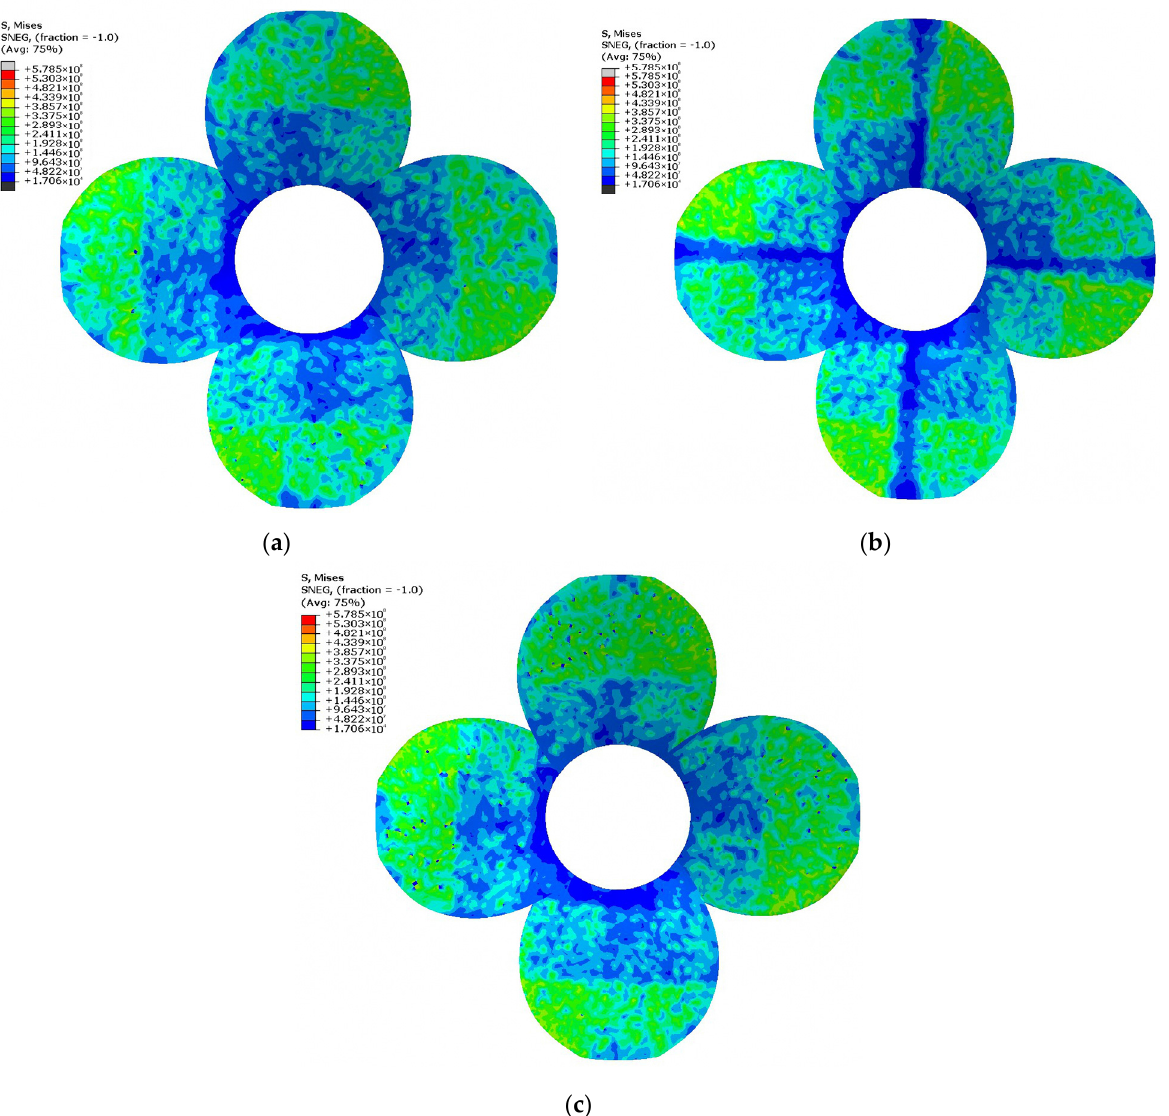
Figure 12. Comparison of the surface stress of the original propeller, the optimization 1 propeller, and the optimization 2 propeller during ice cutting. ( a ) Comparison of surface stress of parent propeller and ice cutting; ( b ) Optimization 1 comparison of surface stress between propeller and ice cutting; ( c ) Optimization 2 comparison of surface stress between propeller and ice cutting .